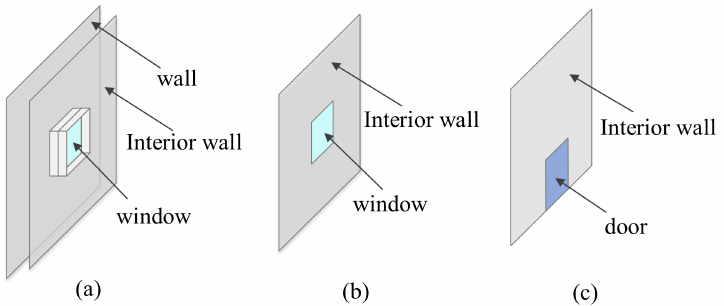
Figure 14. Representation of doors and windows. ( a ) Representation of a window in CityGML. ( b ) Simplified representation of a window. ( c ) Simplified representation of a